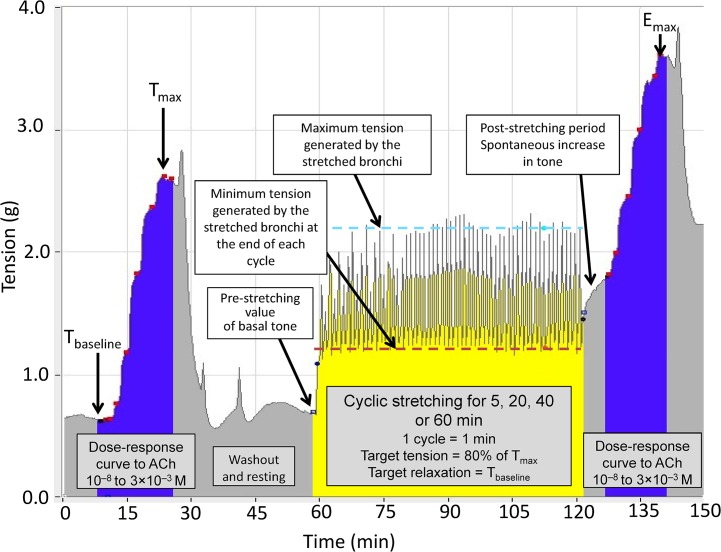
The experimental protocol for the cyclic stretching of human bronchial rings in a 37°C organ bath containing 5 ml of Krebs-Henseleit solution gassed with 95% O2/5% CO2.The illustration is based on data captured from an actual experiment. Tmax: maximum bronchial contraction in response to 3 × 10–3 M acetylcholine (ACh) before cyclic stretching; Tbaseline, resting basal tone. Tbaseline and 80% of Tmax were used to define the settings for cyclic stretching. The expected tension variation generated by the device (80% Tmax—Tbaseline) was compared to the observed values generated by the bronchial rings (maximum tension—minimum tension) in response to the forces imposed by the device (Table 2).The initial test of bronchial reactivity with 3.10–3 M acetylcholine was not represented.